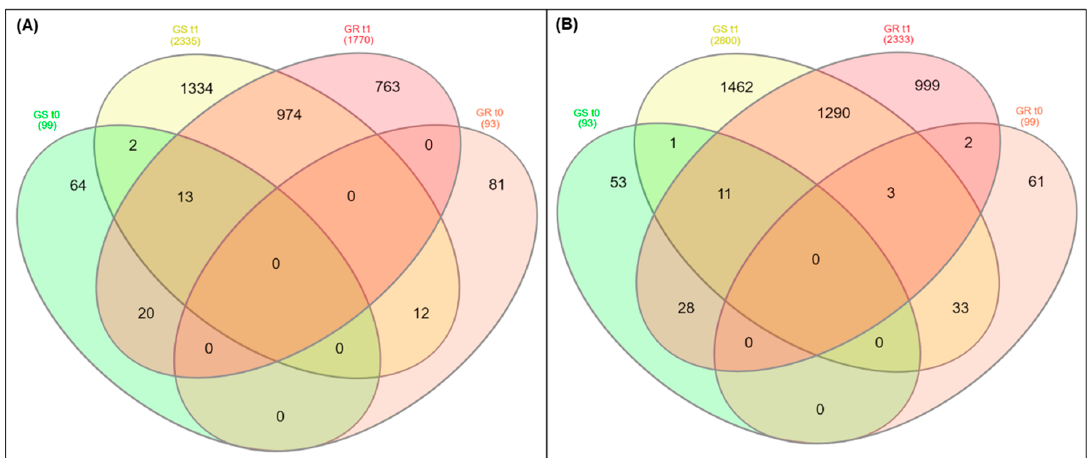
Figure 1. The differential expression results presented in a Venn diagram from transcriptome analysis in glyphosate-resistant (GR) and -sensitive (GS) biotypes of Conyza bonariensis in response to glyphosate treatment. ( A ) Up-regulated; ( B ) down-regulated. t0: without glyphosate treatment; t1: with glyphosate treatment — RNA was obtained from plants collected at several timepoints up to 288 h after treatment and pooled. Genes were filtered according to relative expression (count-number), p- value and false discovery rate (FDR) set at ≤ 0.001.